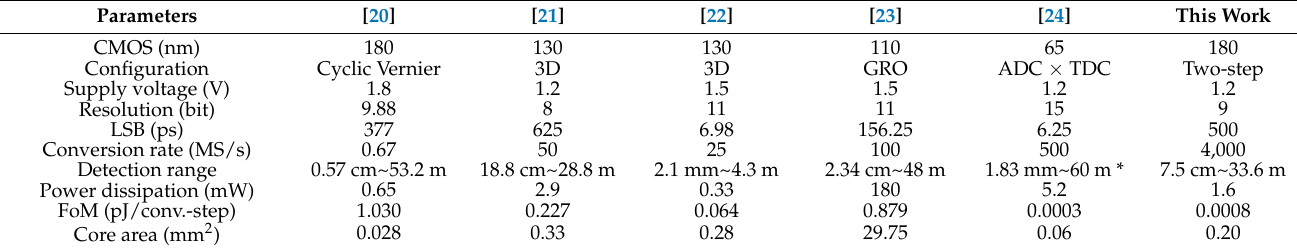
Table 2. Performance comparison of the proposed I-TDC with prior